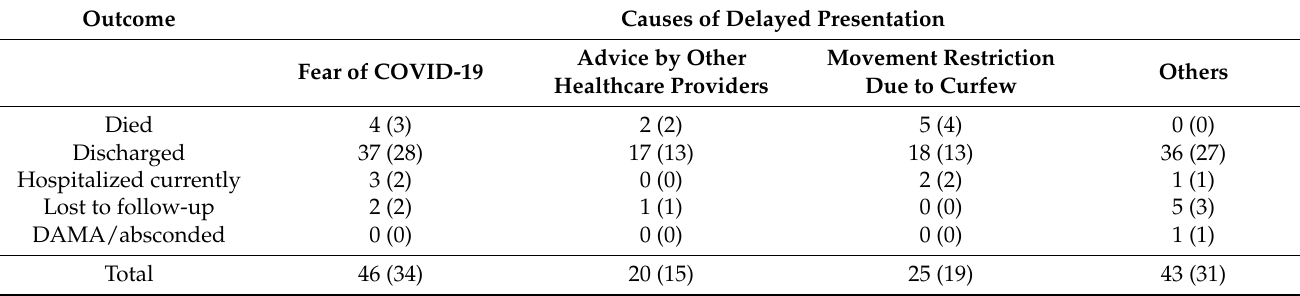
Table 4. The 28-day outcome stratified according to the cause of delayed